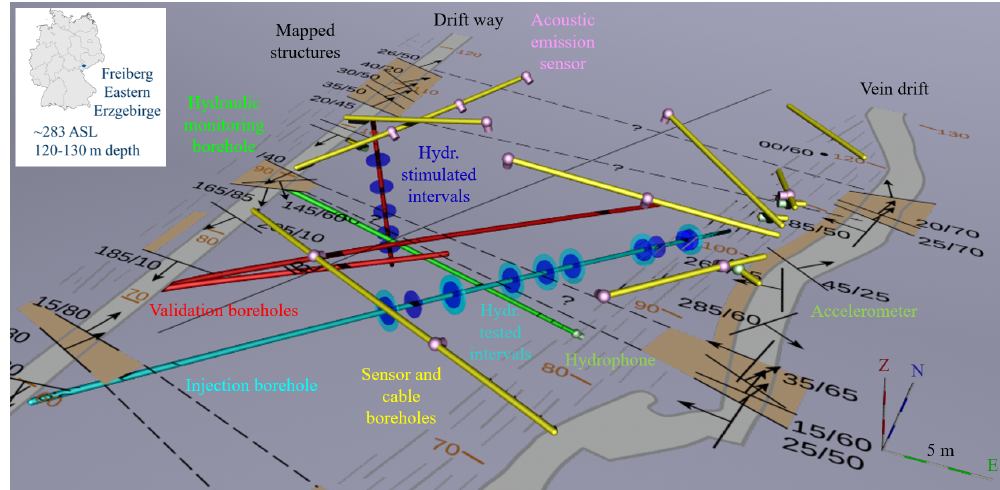
Figure 1. Overview of the borehole network and mapped structures along the galleries at the STIMTEC site in the Reiche Zeche mine. The eastern gallery is the curved vein drift; the western gallery is the straight driftway, which is oriented almost north–south. Deformation zones (brown zones) are marked along the galleries and assumed to belong to connected systems between the galleries based on the orientations of mapped structures identified in the pre-characterisation phase of the experiment. The monitoring system comprises 12 acoustic emission piezo sensors (purple) located in horizontal or upward-going seismic monitoring boreholes (yellow). Three accelerometers (light green) are collocated with AE sensors. A broadband sensor was moved from a short horizontal borehole off the vein drift to the vertical validation borehole (red) in driftway during the course of the experiment. An AE hydrophone was placed at the bottom of the hydraulic monitoring borehole (green) for the last hydraulic testing phase of the experiment. Stimulation intervals (dark blue) in the injection borehole (cyan) and the vertical validation borehole (red) are shown together with hydraulically tested intervals (light blue). Inset shows the regional setting of the mine in Freiberg, Germany.